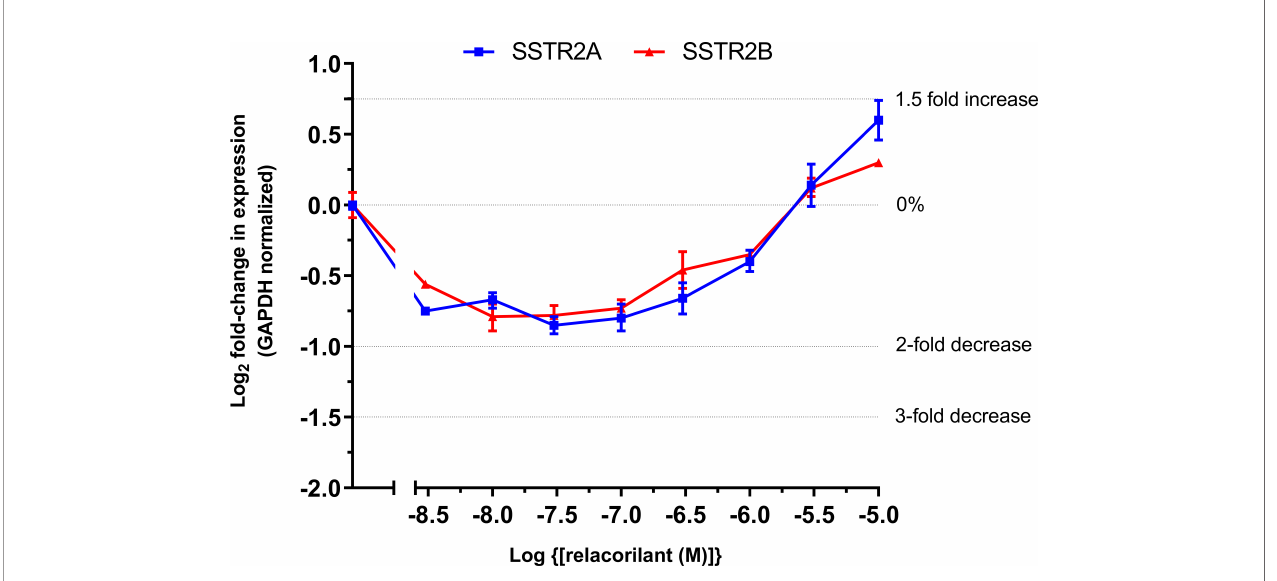
FIGURE 2 | Log 2 fold change in SSTR2 mRNA in murine At-T20 cells upon treatment with increasing concentrations of relacorilant for 24 h in the presence of 100 nM dexamethasone. 0%, 2-fold, and 3-fold inhibition and 1.5-fold increase in levels are highlighted by dotted lines on the y-axis. Zero relative expression is in the absence of dexamethasone. Data points show average fold change compared to baseline and SD error bars. Data are technical replicates with an underlying